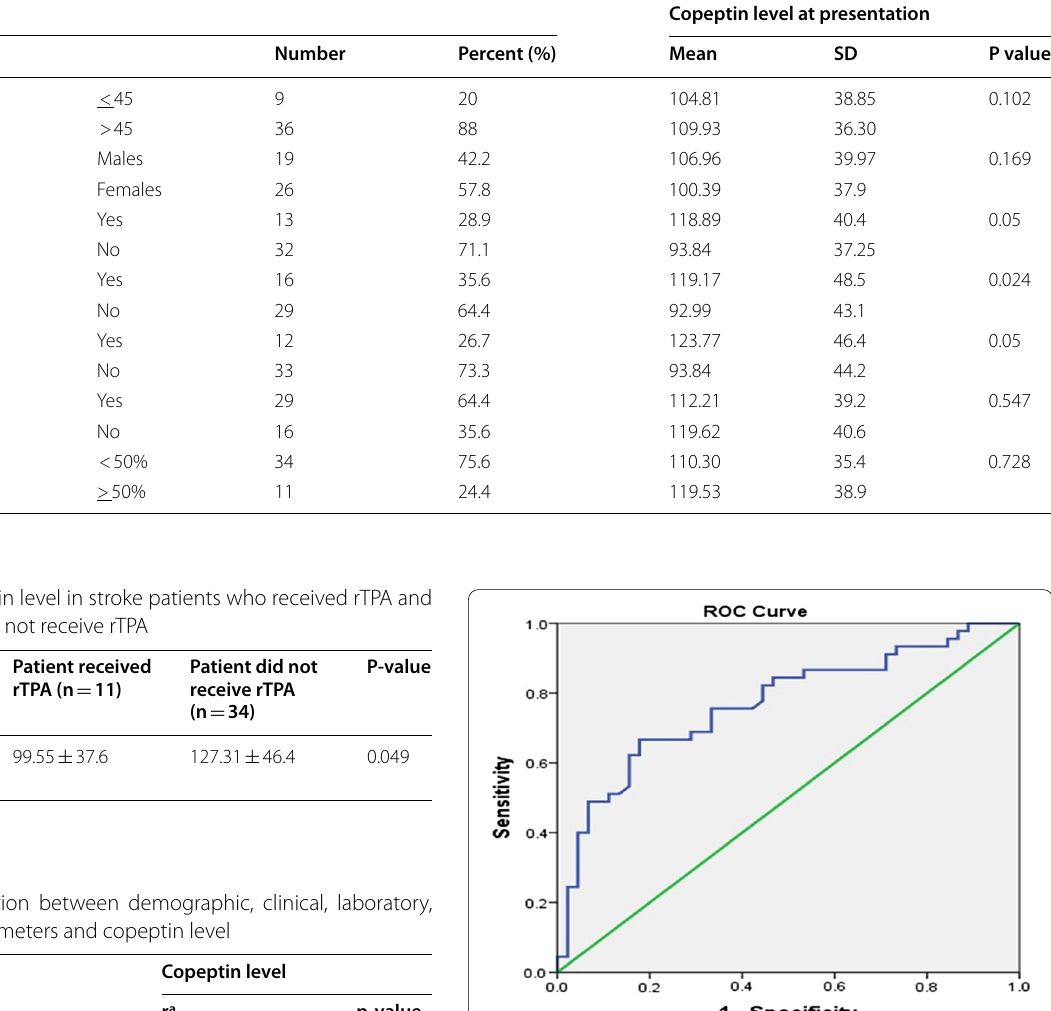
(the area under the curve 0.769, 95% confidence inter- val 0.671 to 0.868, P-value